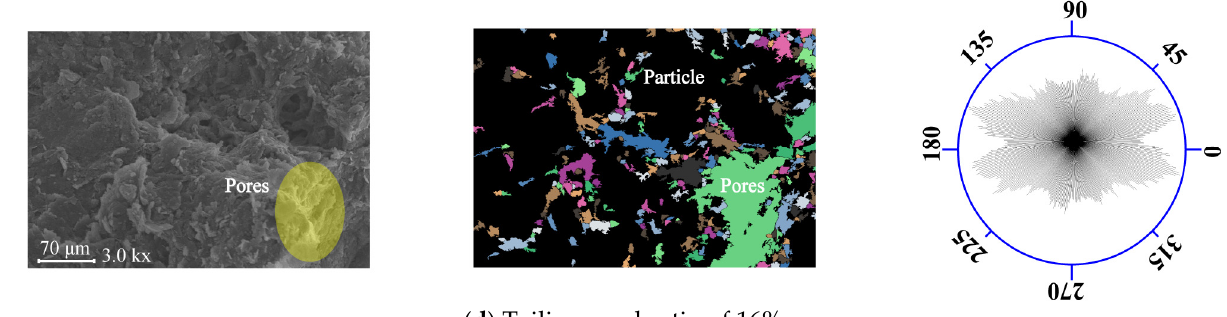
Figure 11. SEM microstructures of different waste residue soils.